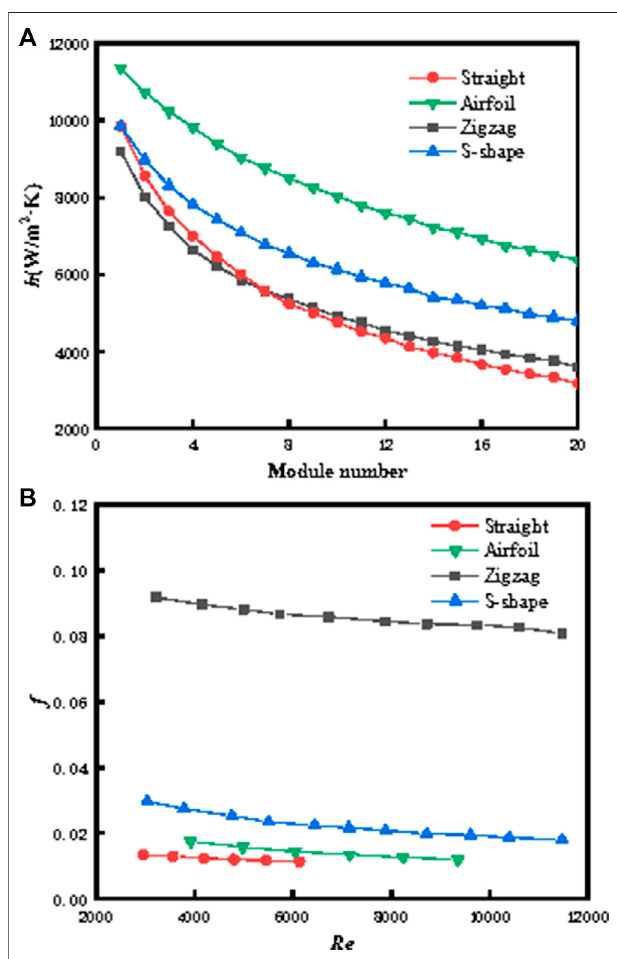
FIGURE 3 | (A) Effect of channel structure on heat transfer coef fi cients (Yoon et al., 2014). (B) Effect of channel structure on Fanning friction factors (Ngo et al., 2006; Yoon et al.,